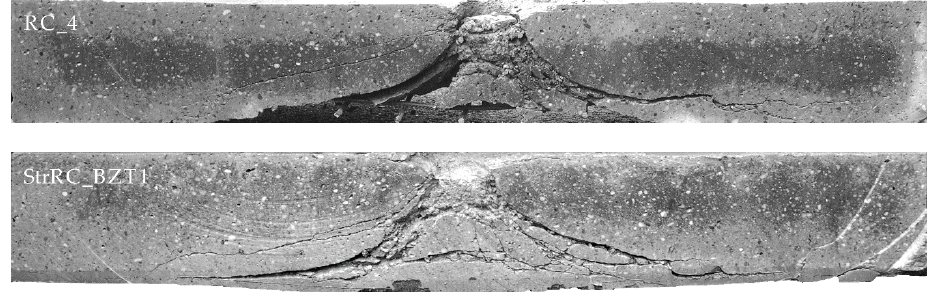
Figure 10. Comparison of the saw cuts of the plates RC_4 and StrRC_BZT1; photos: M. Hering.